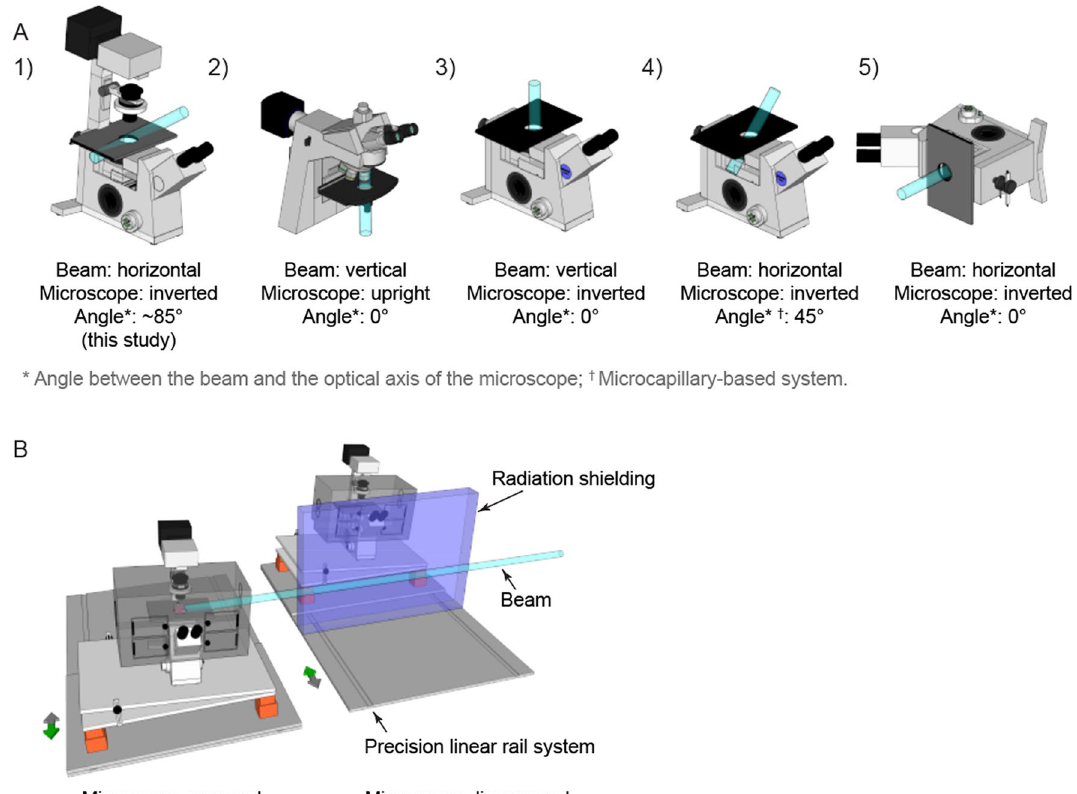
Figure 5. Different arrangements of the microscope, relative to the particle beam, in existing imaging setups at particle accelerator facilities. ( A ) Schematic illustration of the existing arrangements, with references to the relevant publications. (1) this study; (2) refs 18,31,32,35,38 ; (3) Refs. 22,34,40 ; (4) Ref. 37 ; (5) Refs. 9,19,23,36,39,54,55 . ( B ) Considered future automated microscopy setup at the KVI-CART facility in Groningen, The